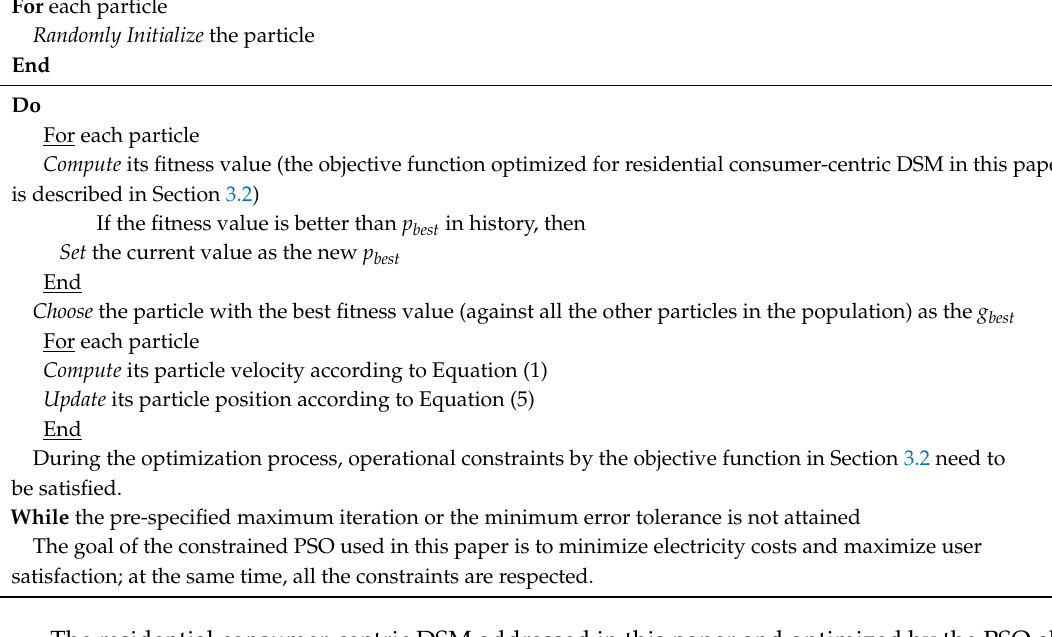
Algorithm 1: The PSO procedure with its variants proposed in [26] For each particle Randomly Initialize the